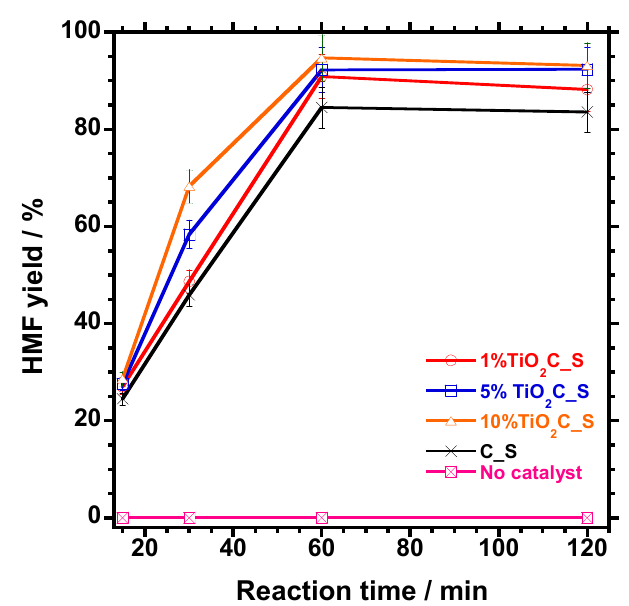
Figure 7. Effect of reaction time on the dehydration of fructose into HMF in DMSO solvent.